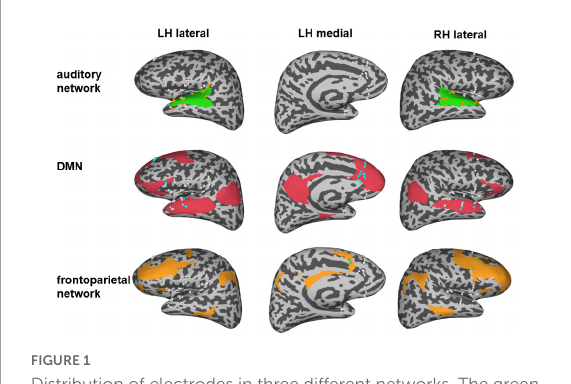
FIGURE1 Distribution of electrodes in three different networks. The green region represents the auditory network and the orange electrodes indicate the electrodes in the auditory network. The red region represents the default mode network (DMN), and the blue electrodes indicate the electrodes in the DMN. The orange region represents the frontal network and the green electrodes indicate the electrodes in the frontal network. Note that the white electrodes represent electrodes that were implanted outside the corresponding